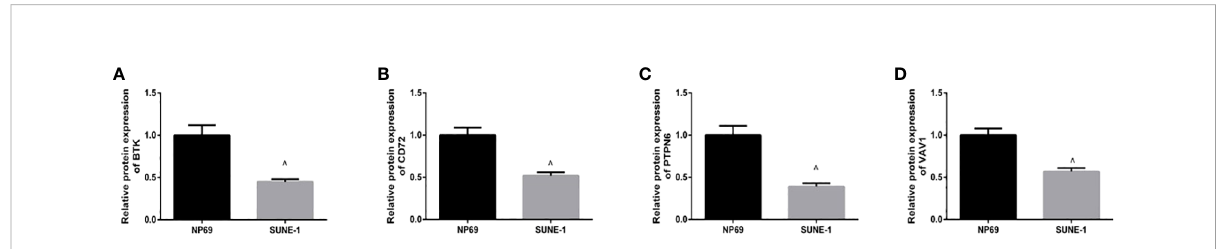
FIGURE 6 qRT-PCR. (A) Expression level of BTK; (B) expression level of CD72; (C) expression level of PTPN6; (D) expression level of VAV1. ^ indicates P<0.05 compared with the NP69 group.